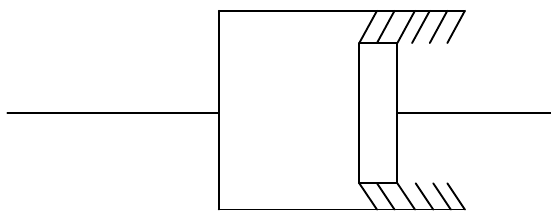
Figure 16. Creating a new component model.